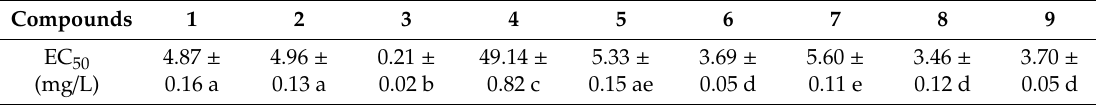
Table 3. EC 50 values of active compounds against S. sclerotiorum .